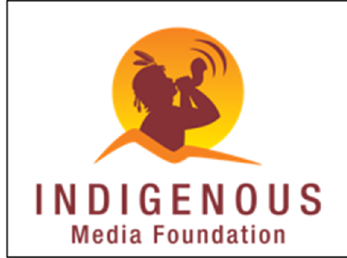
Figure 4. Indigenous Media Foundation, a not-for-profit organization of Nepal that supports Indigenous Television of Nepal. Source: www.indigenousmediafoundation.org, accessed on 11 September 2021.